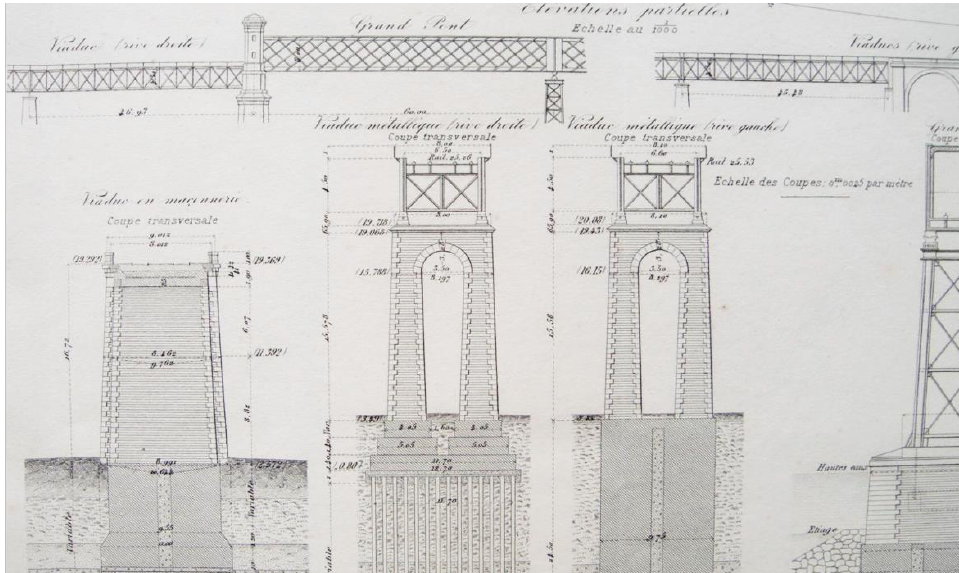
Figure 23. Cubzac Bridge, Pilaster structure detail and general elevation, designed by Eiffel. Source: Taken from the Annales des Ponts et Chaussées Gravées by Macquet illustrating the notice on the construction of the Cubzac bridges over the Dordogne. the École des Ponts Paris Tech, an associated center in civil engineering of the National Library of France, provides access to the full text of the Annales des ponts et chaussées (period 1831 – 1931), through the Gallica digital library. In this sense, we see how Daly tries to give a mathematical basis to this bridge